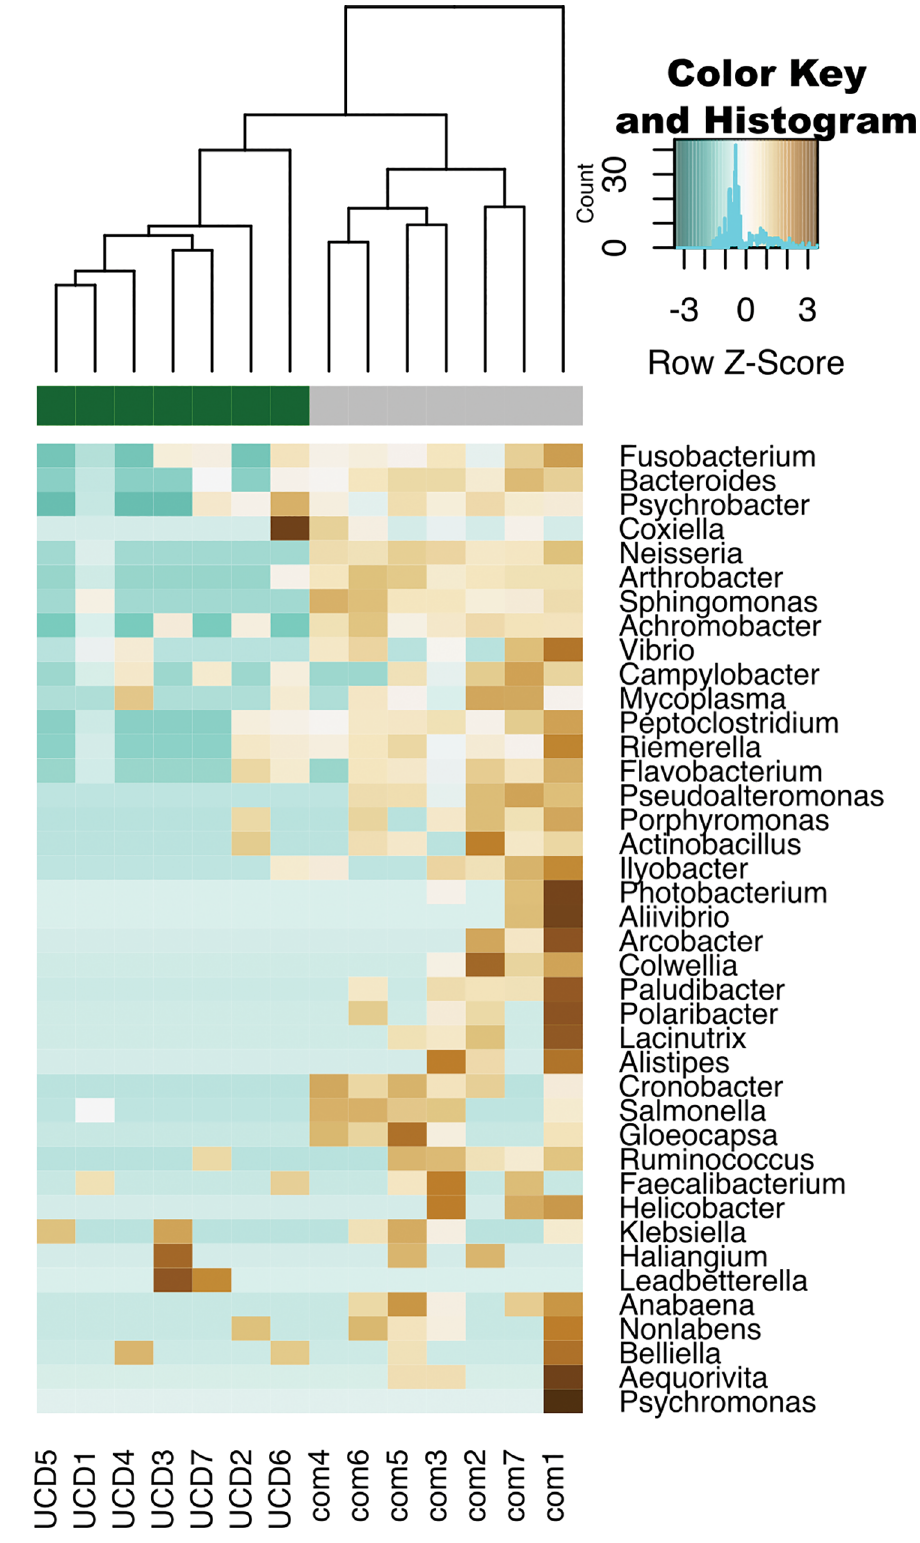
Fig 4. Microbial genera community analysis of brain tissues from comparative (com) and unknown cause of death (UCD) harbor seals. Heatmap hierarchical clustering of the 50 bacterial genera with the highest